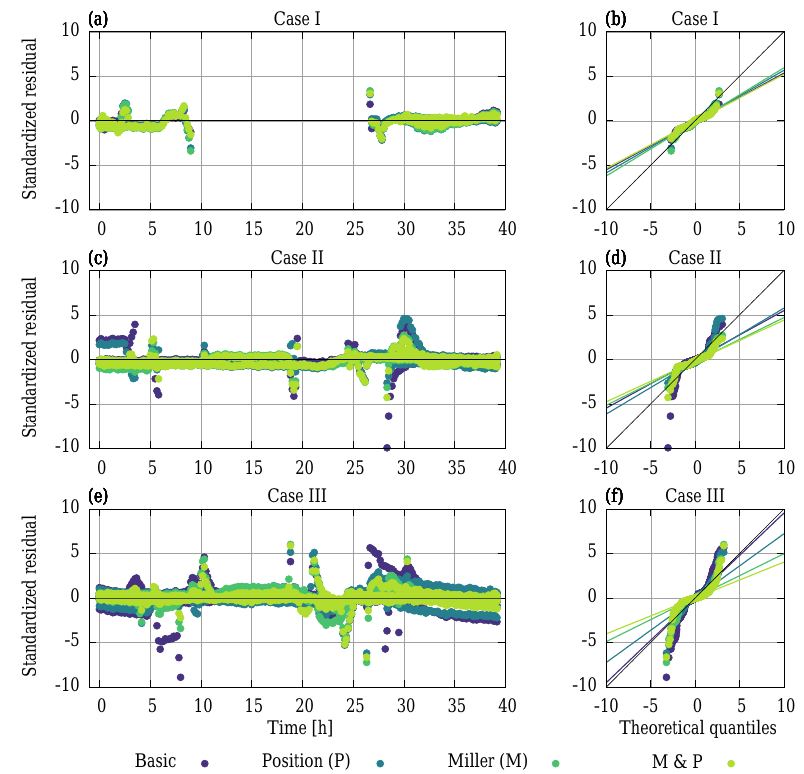
Figure 7. For the 1-D study, the standardized residuals of the best ensemble member are visualized over time (a, c, e) and over the theoretical quantiles of a Gaussian with the estimated standard deviation of the TDR measurements (0 . 007; b , d , f ). The cases are analyzed with four setups: basic, position, Miller, and Miller and position. The more sensors per material are used in the inversion, the worse the representation of the basic setup gets. In this case, representing uncertainties with respect to the sensor position and small-scale heterogeneities improves the representation substantially. The decreasing slope of a linear fit (thin lines in the probability plots), which is based on the standardized residuals within [− 2 , 2 ] theoretical quantiles, also indicates this